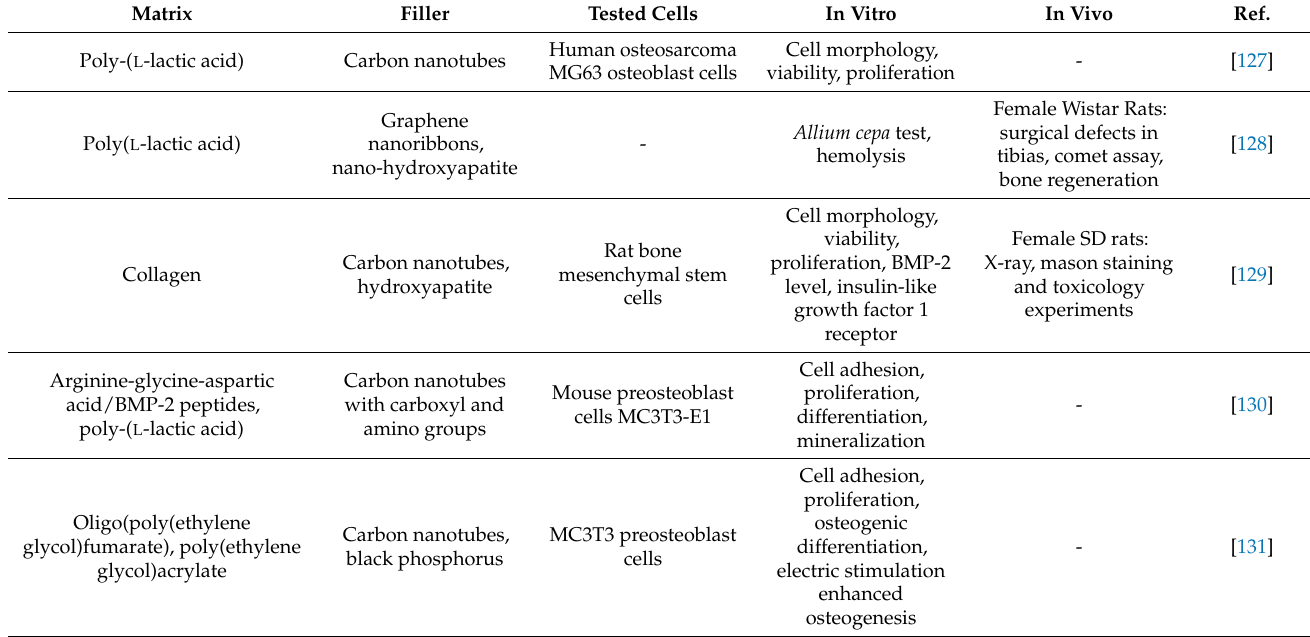
Table 3. Summary of composite materials containing nanocarbons developed for bone healing and regeneration. Matrix Filler Tested Cells In